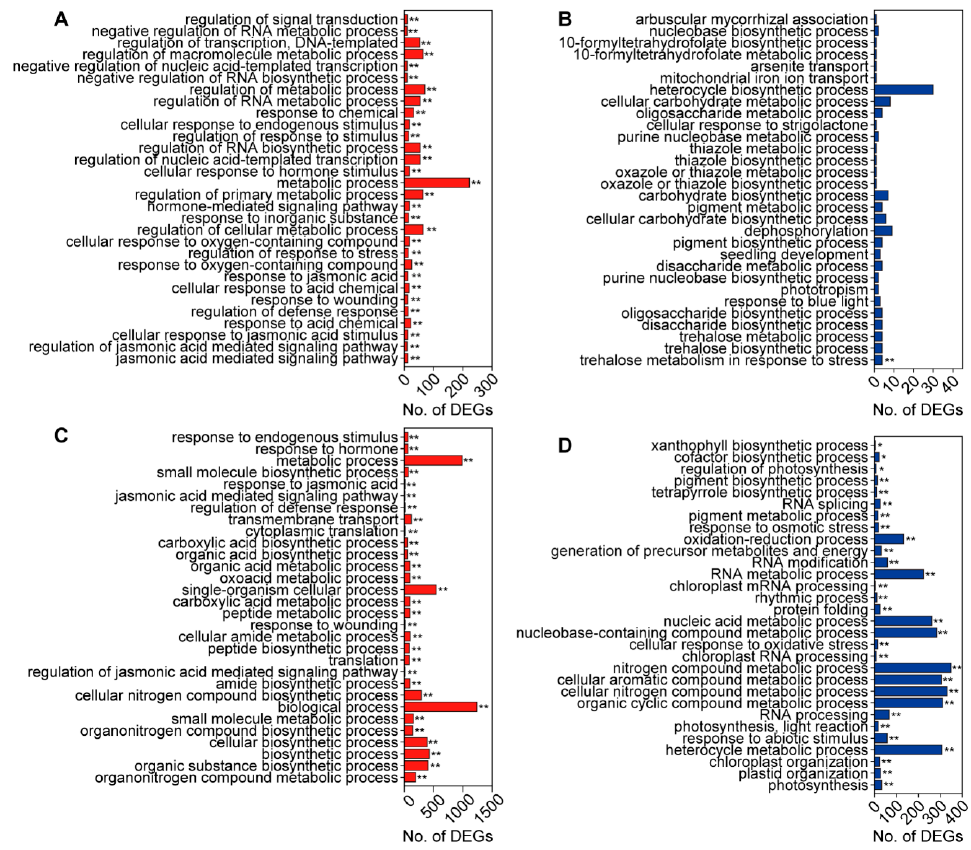
Figure 5. The top 30 enriched gene ontology (GO) terms of the di ff erentially expressed genes (DEGs) in rice leaves infested with C. medinalis at early post-infestation (1 h) and late post-infestation (24 h) relative to control plants. ( A , C ) GO enrichment analysis of upregulated DEGs at 1 and 24 h post-infestation, respectively. ( B , D ) GO enrichment analysis of downregulated DEGs at 1 and 24 h post-infestation, respectively. Asterisks indicate statistically significant di ff erences: * padj < 0.05, ** pddj < 0.01 via